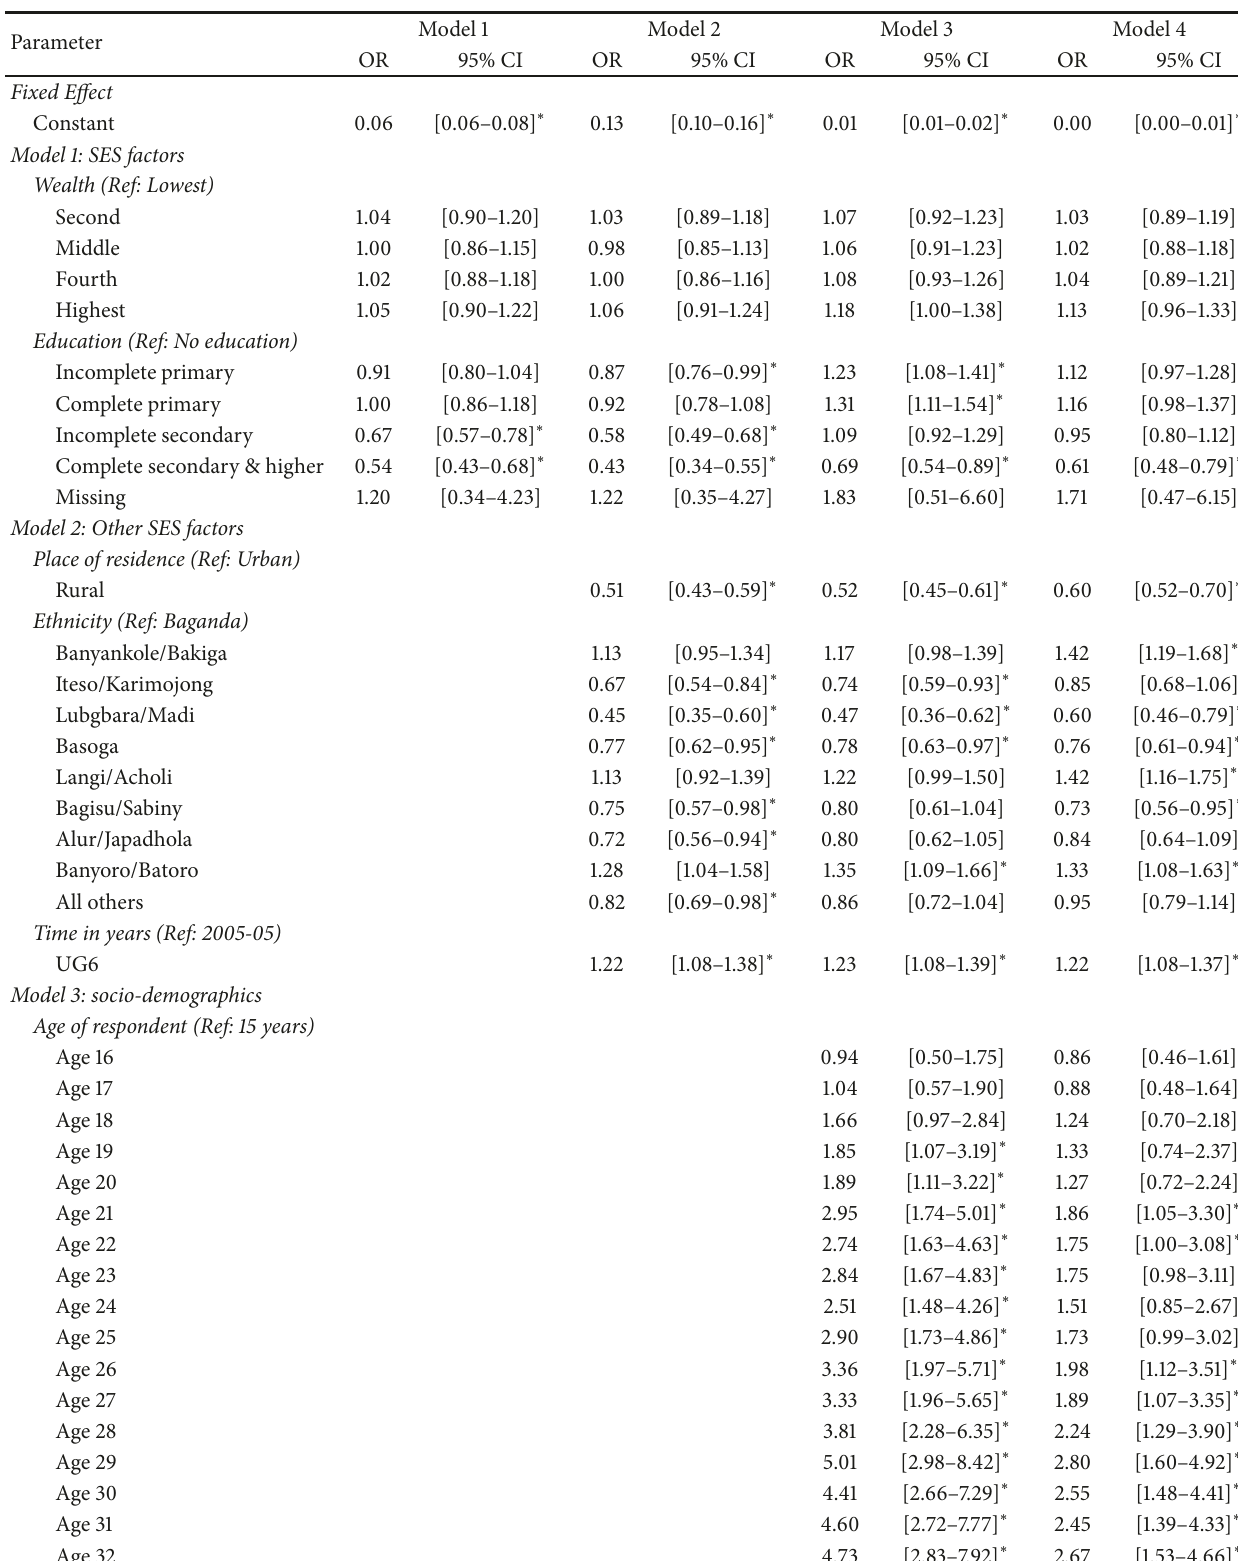
Table 3: Odds ratios (OR) of being HIV positive for women and men, Uganda AIS, 2004-2005 and 2011 ( 𝑛 = 39 , 766 ) controlling for age in single-year dummy